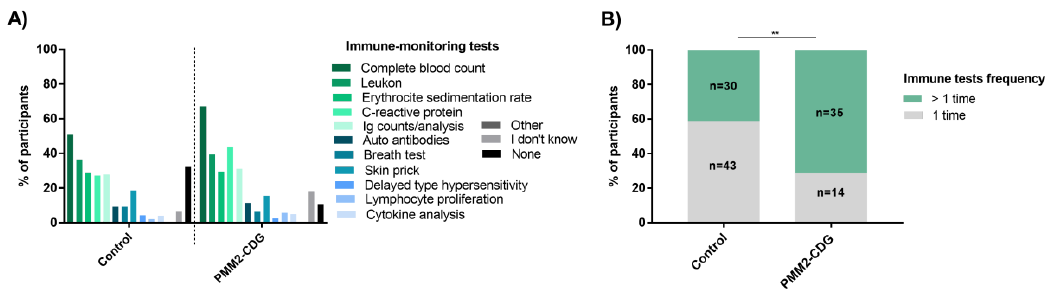
Figure 8. Immune testing. ( A ) Types of immune tests reported by PMM2-CDG and control participants. Only C-reactive protein (CRP) is significantly di ff erent between PMM2-CDG and control participants ( p = 0.0043 / OR = 1.87). Statistical significance refers to the comparison between the participants who identified CRP testing and those who did not in the PMM2-CDG and control groups; ( B ) Immune testing frequency. Statistical significance refers to the comparison of participants reporting to have done immune tests once to others reporting having done the tests with greater periodicity, at least twice, which were combined into the “ > Once” group ( p = 0.0015 (**) / OR = 3.54). Participants unaware or uncertain of the frequency of testing were excluded from this analysis. Only participants reporting the presence of immune-related manifestations (prior to this question) and capable of communicating the frequency of testing had to reply to this question. Statistical significance was calculated using Fisher’s exact test.